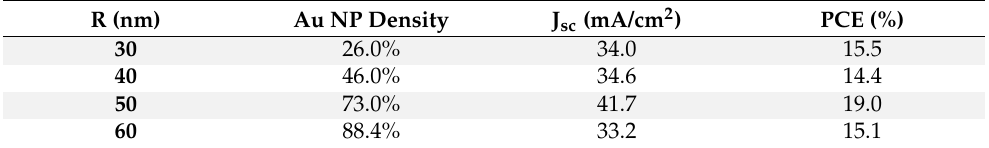
Table 5. Au NP density, short-circuit current density, and overall efficiency for different NP materials.